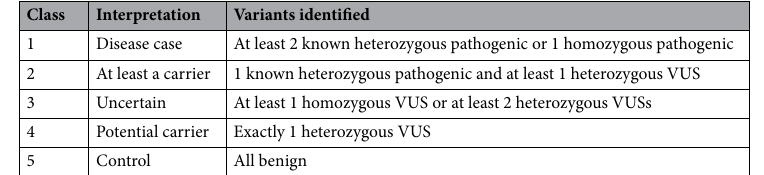
Table 2. Categorization of individuals based on classification of genetic variants identified in personal genome data. For each gene known to cause a given IEM, variants identified in a personal genome were assigned a pathogenicity category based on the application of the ACMG/AMP guidelines. Secondly, the observed zygosity (e.g., heterozygous, hemizygous or homozygous) of the variants identified in an individual’s exome was considered alongside the expected Mendelian mode of inheritance for the disease gene (i.e., autosomal recessive).